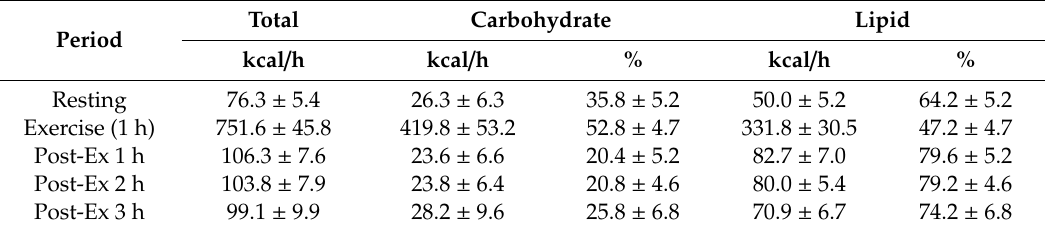
Table 2. Energy expenditure and substrate oxidation at rest, during, and after exercise.